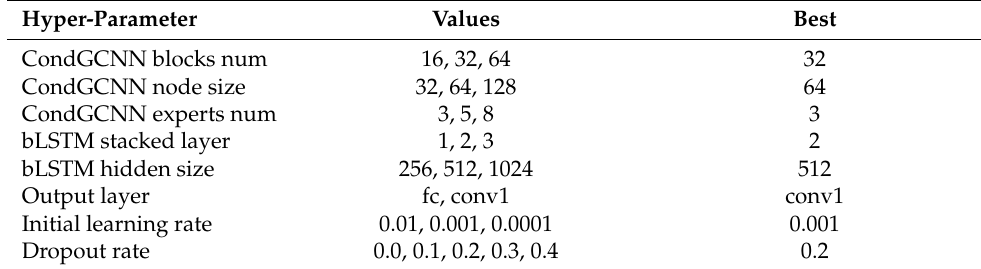
Table 5. Hyper-parameter space and best values.